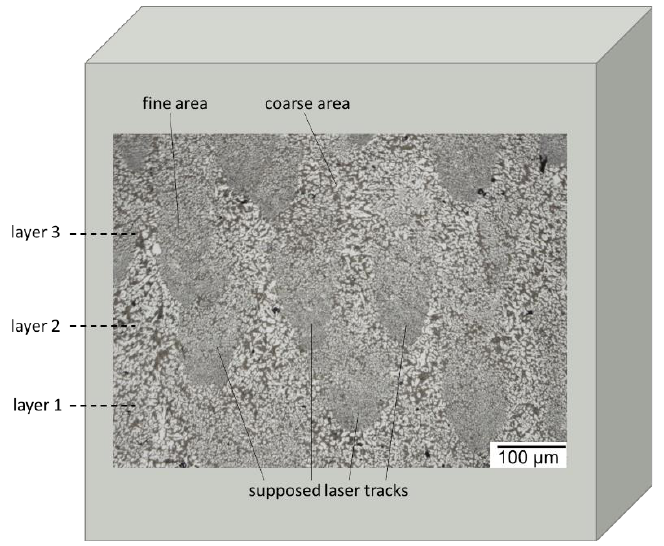
Figure 3. Light microscope image of an etched longitudinal cut of an AlSi50 sample with indicated possible laser tracks and layers.